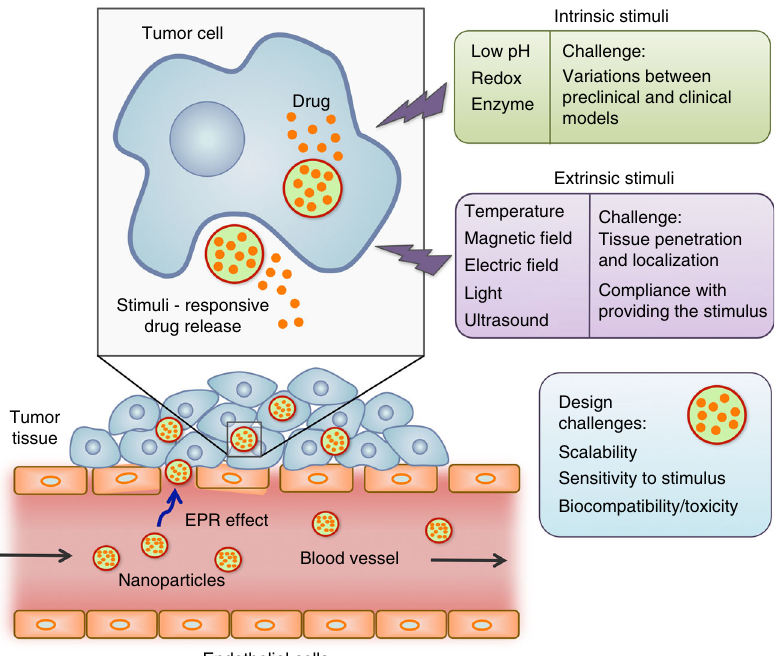
Fig. 4 Challenges to clinical translation of stimuli-responsive NCs. Controlled-switch NCs designed to prevent premature drug release face challenges associated with the type of stimulus on which they are based. Other than that, additional design challenges for the NCs themeselves include scalability, sensitivity, and response to the stimulus, biocompatibility, and